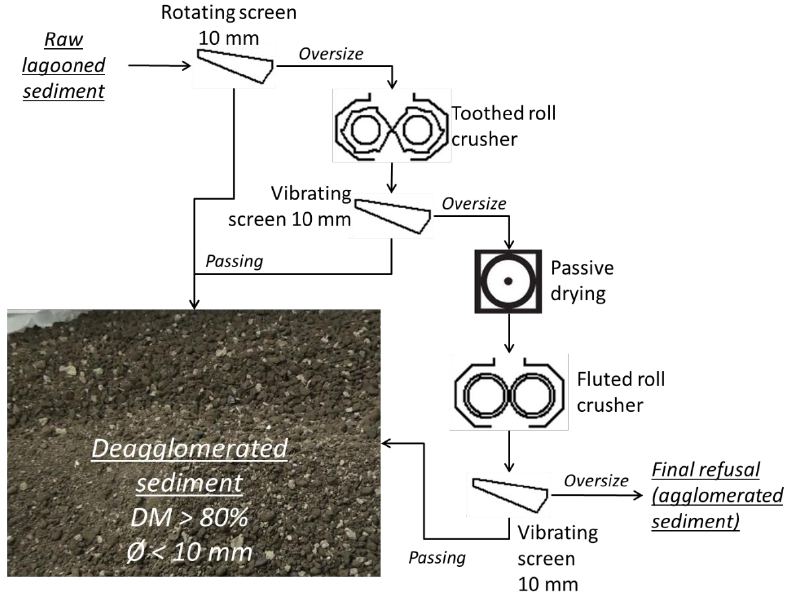
Figure 11. Deagglomeration process for the large batch production on the ALS sediment.